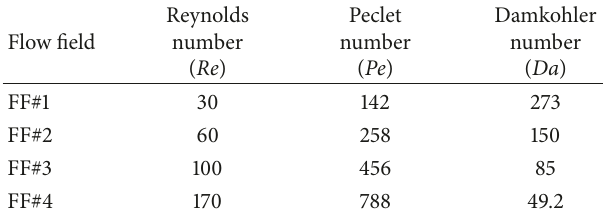
Table 1: Reynolds number, Peclet number, and Damkohler number in